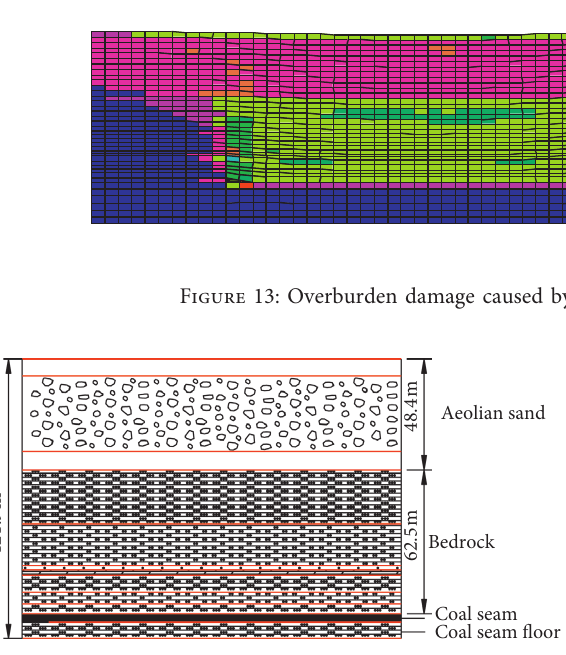
Figure 14: Similar simulation model. Table 5: The main mechanical and geometric parameters of the model.